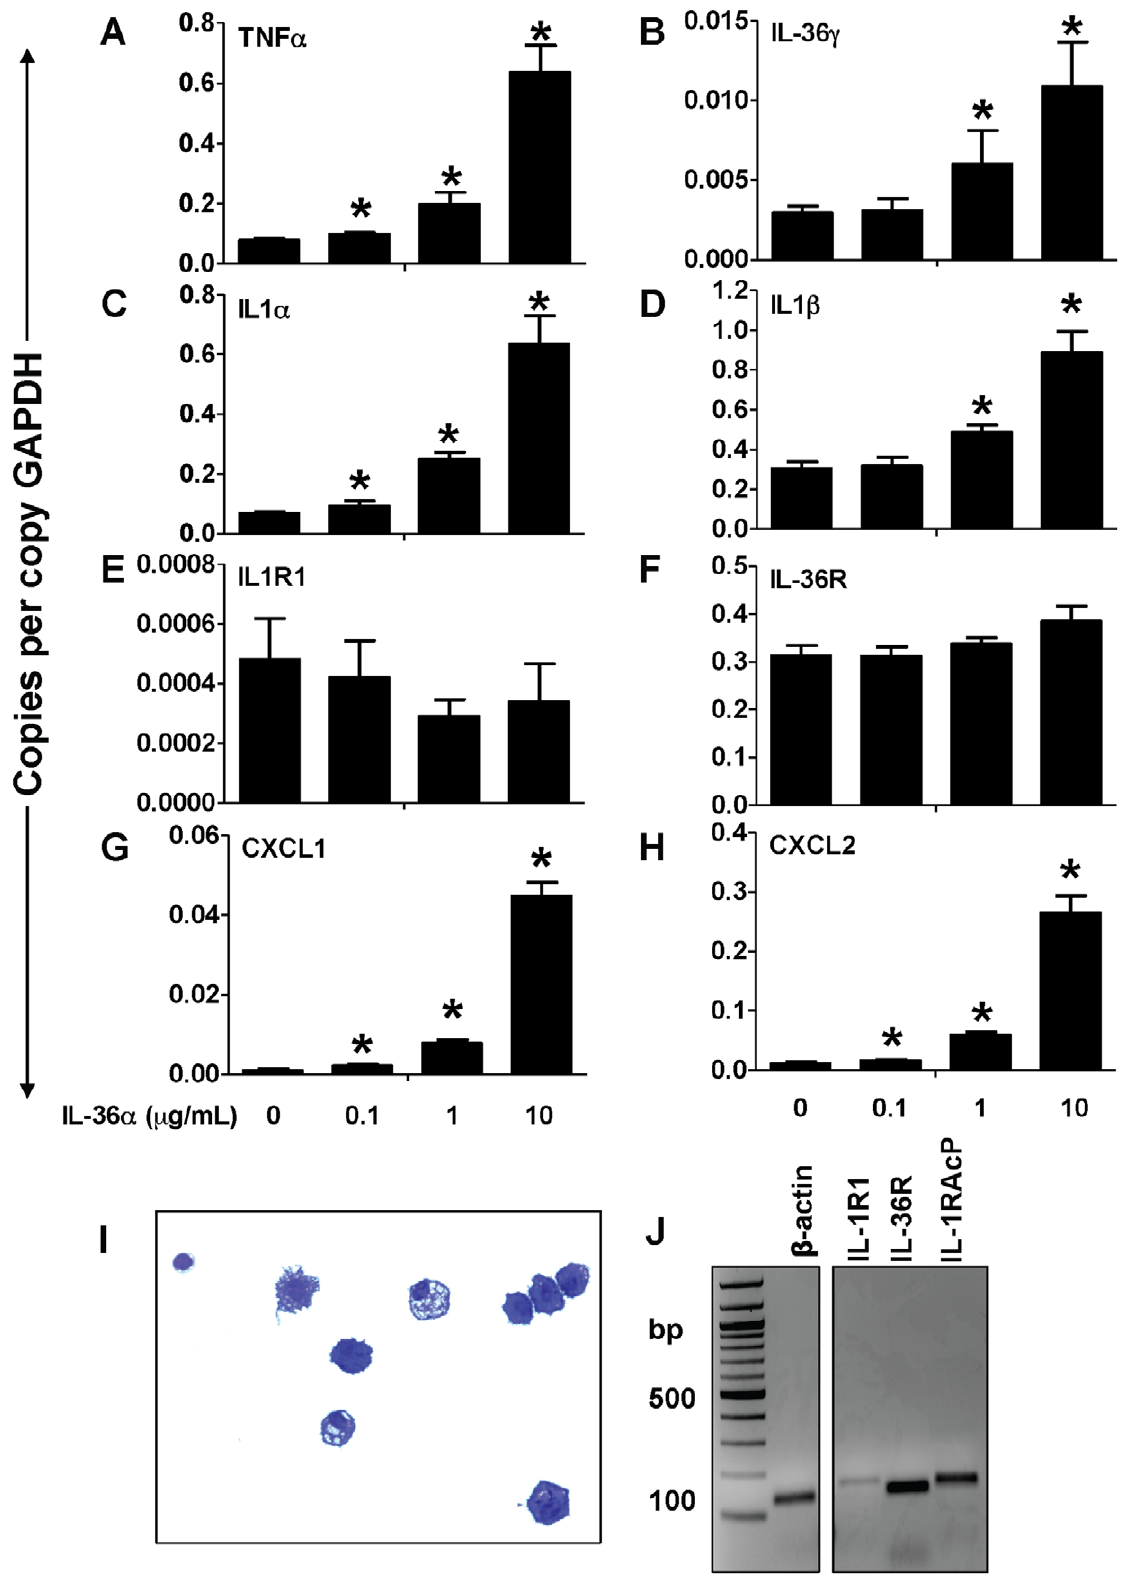
Figure 6. IL-36 a induced the expression of proinflammatory cytokines and chemokines in splenic CD11c + cells. A–H) Transcript expression of early response cytokines (TNF a , IL-1 a , IL-1 b , IL-36 c ), the classical IL-1 receptor IL-1R1, the novel IL-1 cytokine cluster receptor IL-36R as well as the neutrophil specific chemokines CXCL1 and CXCL2 in splenic CD11c + cells 2 h following incubation with increasing concentrations of IL-